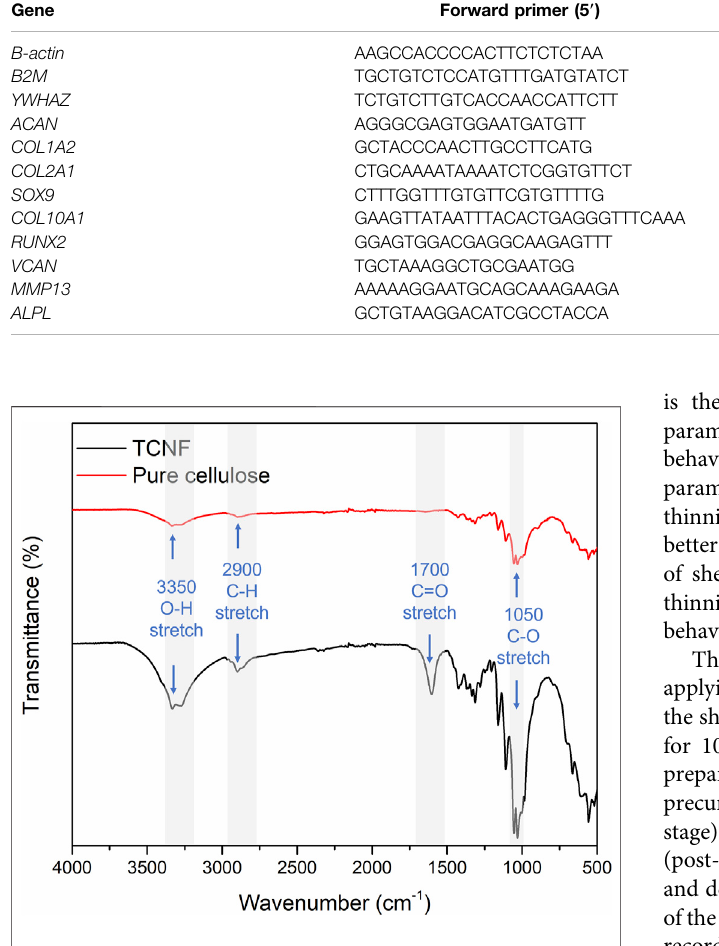
FIGURE 2 | Fourier transform infrared spectroscopy of the pure cotton cellulose and